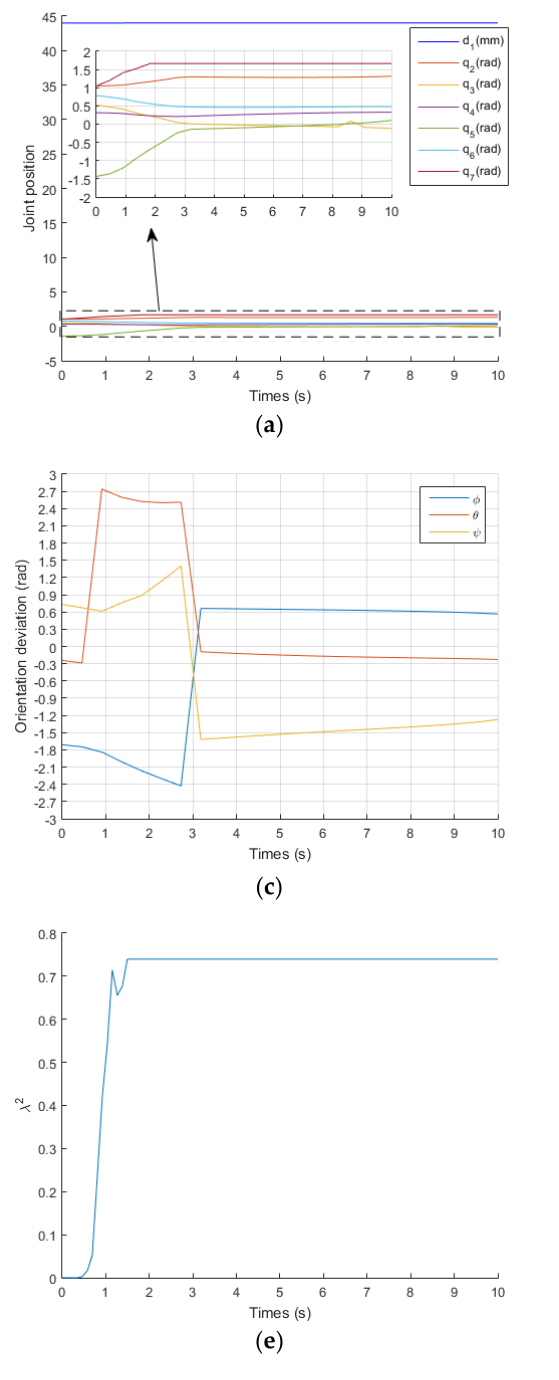
Figure 7. Simulation results obtained with the GPM. ( a ) the change curve of joint position; ( b ) the change curve of position deviation; ( c ) the change curve of orientation deviation; ( d ) the change curve of σ min ; ( e ) the change curve of λ 2 ; ( f ) the change curve of joint velocity.